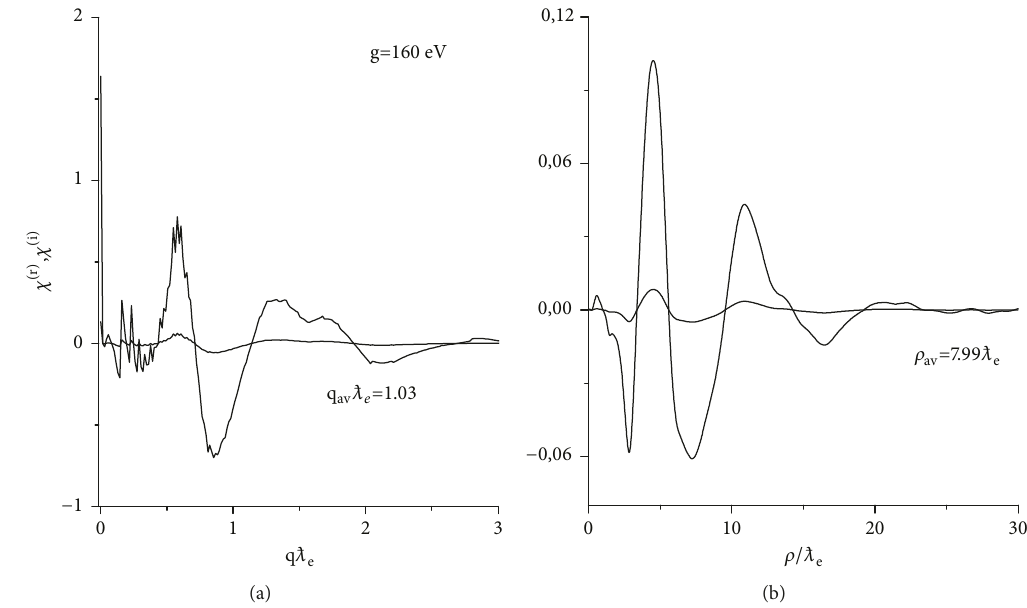
Figure 2: The momentum wave function (a) and the coordinate wave function (b) for the massless boson energy 160eV. The parameter 𝑓 = 65 0